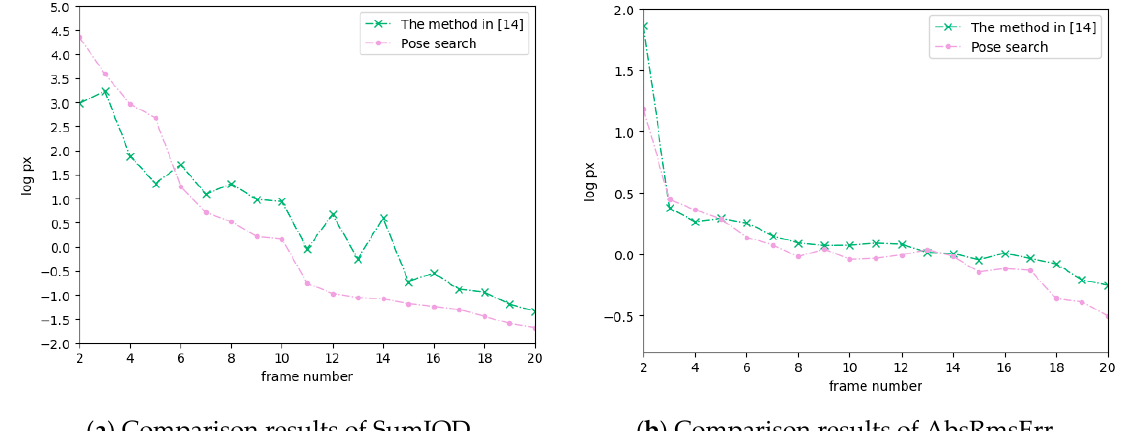
Figure 10. The method in [14] (Generated pose) vs. pose search (Generated pose + SumIOD). The green dotted line is generated by the method in [14]. The magenta dotted line is obtained by our proposed pose search algorithm, which takes a generated pose as the initial solution and SumIOD as the loss function.